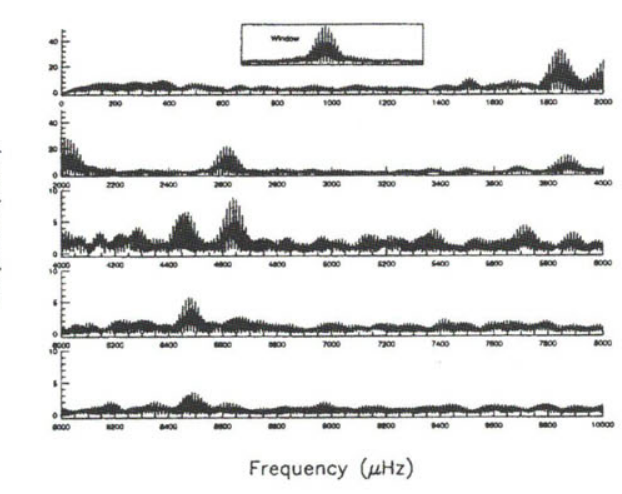
Fig. 18. The FT for the February 1991 data on HL Tau 76.